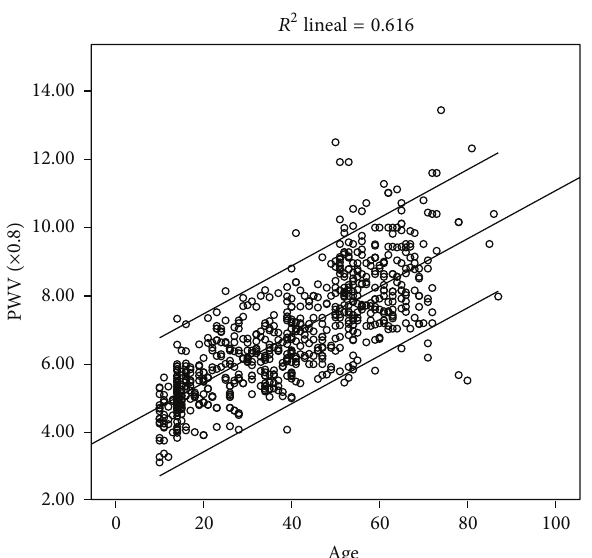
Figure 1: Scatter graph showing the relationship between mean PWV (mean and CI 95%) and age in the study population ( 𝑛 = 780 ).